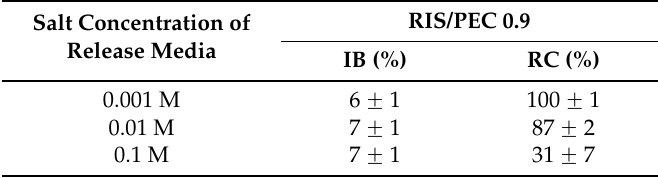
Table 5. Comparison of initial burst (IB) and residual content (RC) for RIS/PEC in dependence of salt concentration of release media.